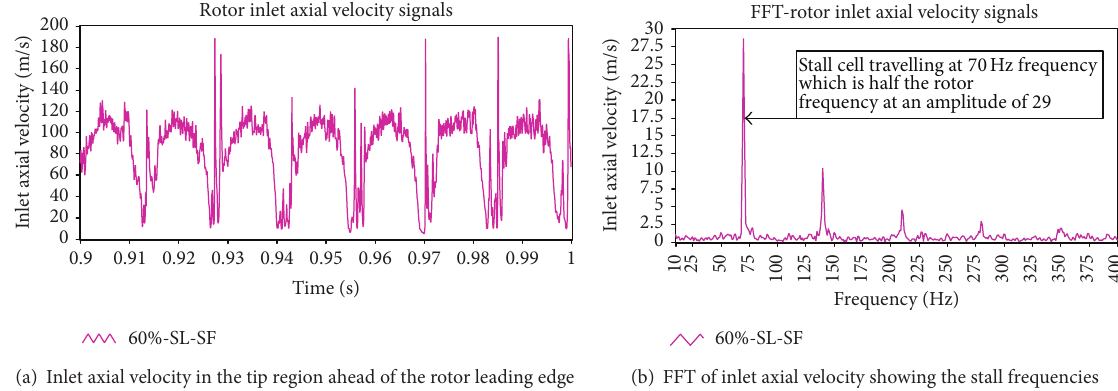
Figure 13: Variation of inlet axial velocity for the solid casing at stall flow (SF) condition.